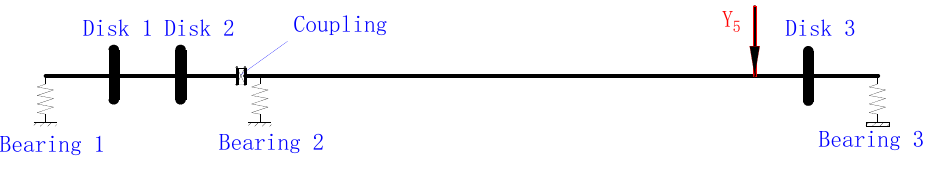
Figure 3. The support scheme of the inner rotor.